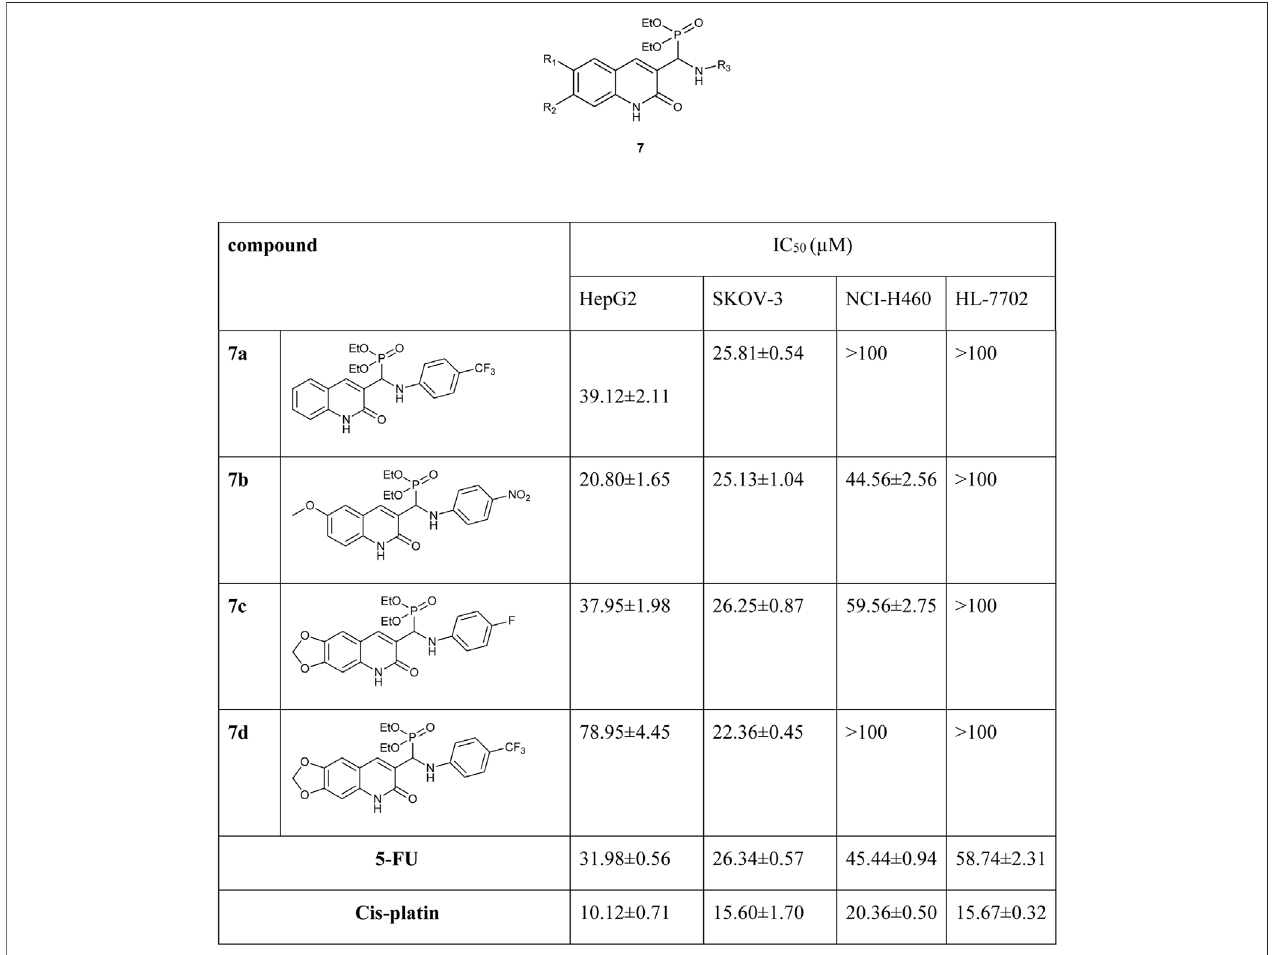
FIGURE 1 | Structure of the compound 7 and its biological